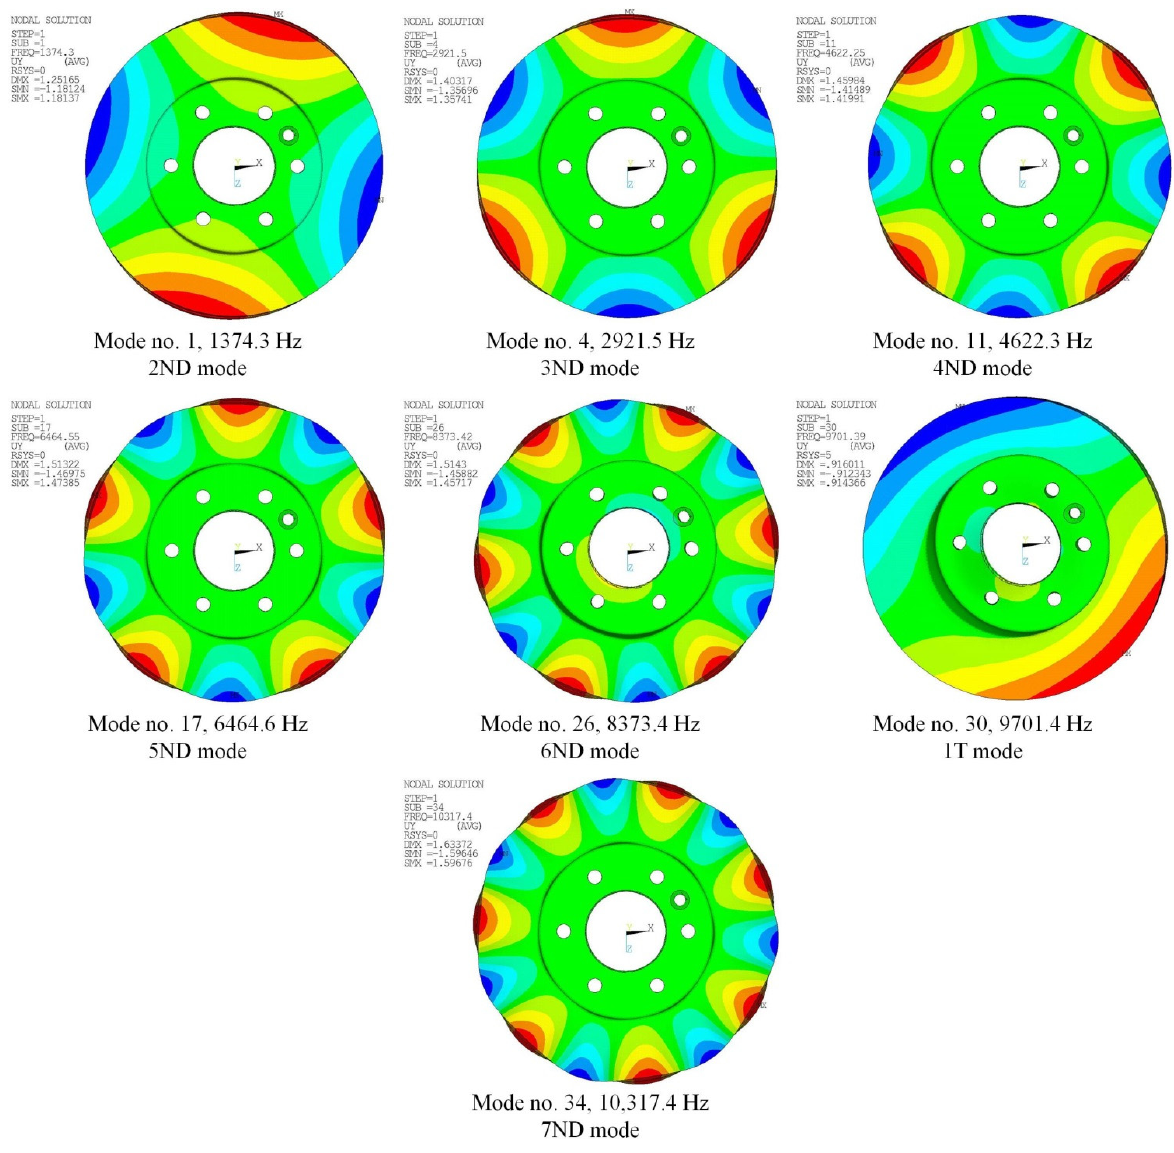
Figure 8. Nodal diameter (ND) and tangential (T) mode shapes and their frequencies for the vented brake rotor.